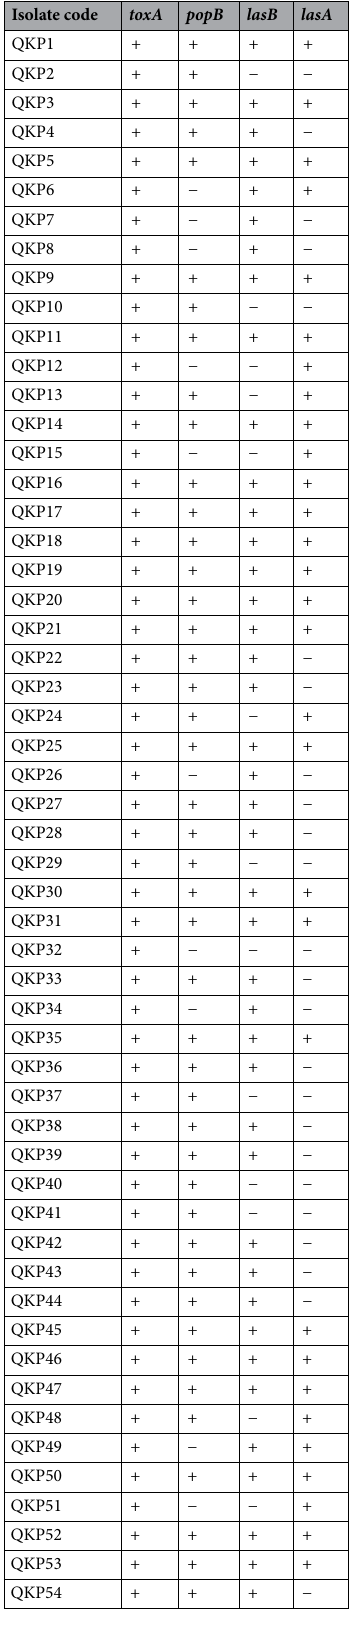
Table 4. Distribution of virulence genes among the P. aeruginosa